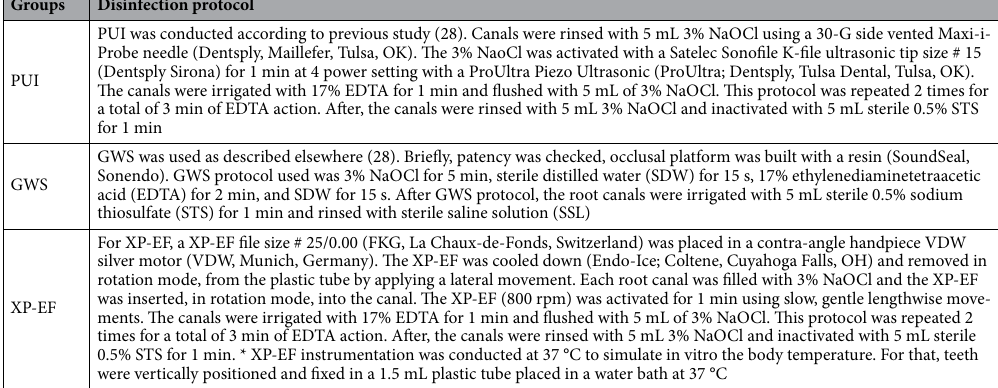
Table 1. XP-EF, GWS, and PUI disinfection protocols. PUI, passive ultrasonic irrigation; GWS, GentleWave system; XP-EF, XP-Endo